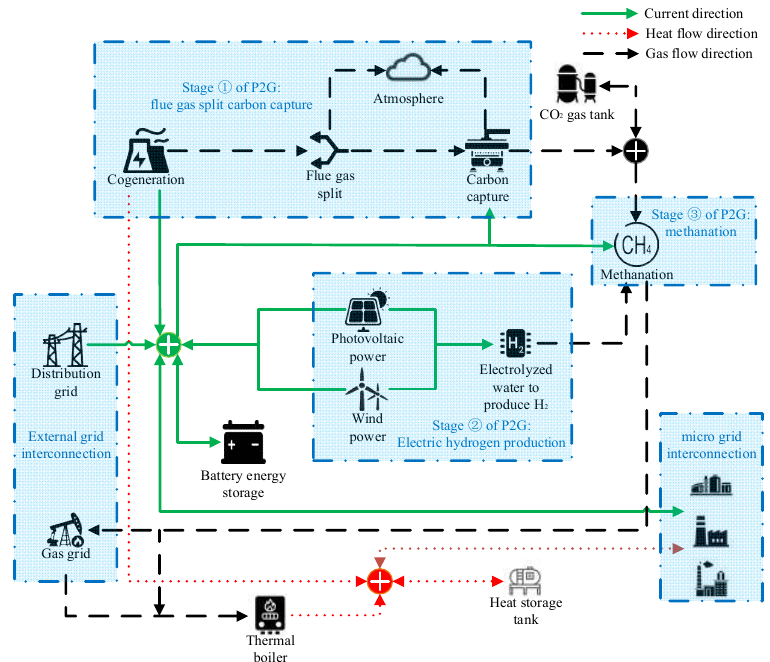
Figure 2. Low-carbon micro-grid architecture diagram introducing P2G and energy sharing.